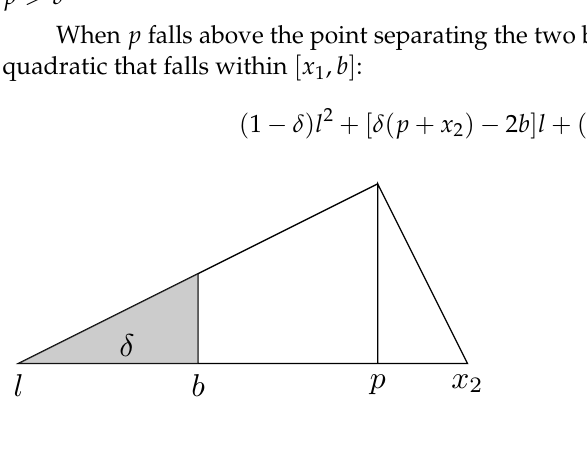
Figure A2. Point estimate in higher